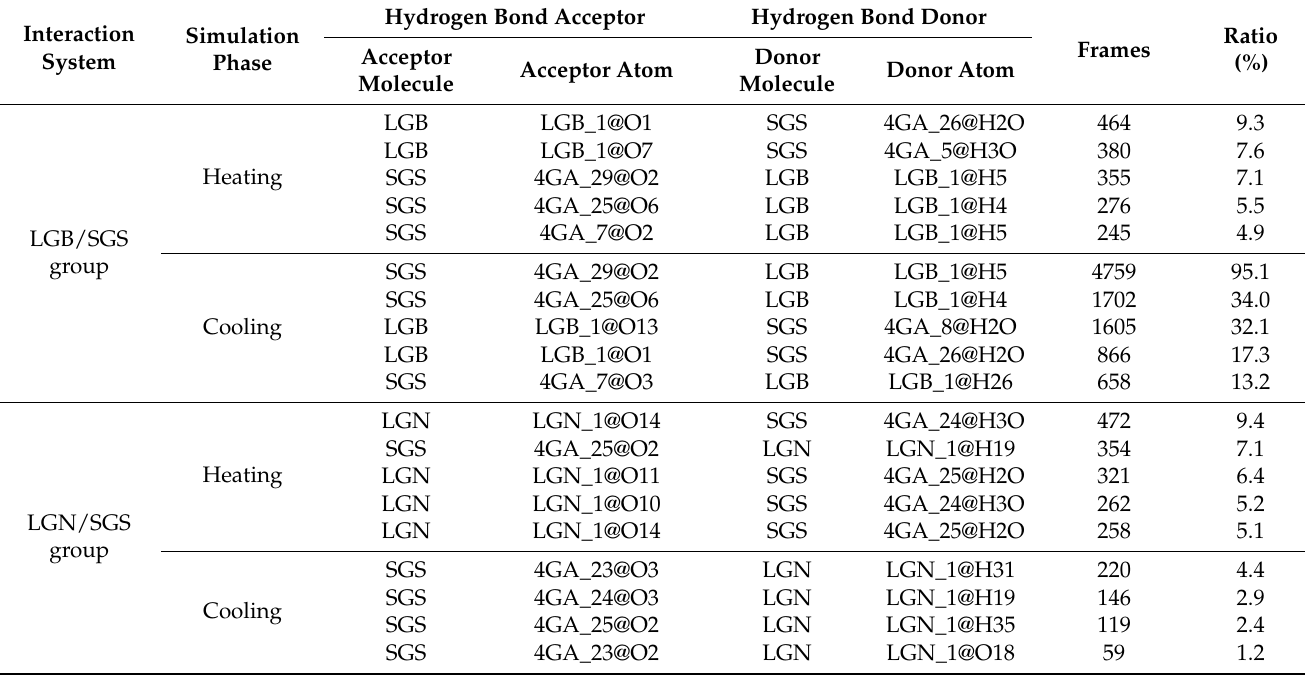
Table 4. The intermolecular hydrogen bonds between two SGS chains and the phenolic compounds of